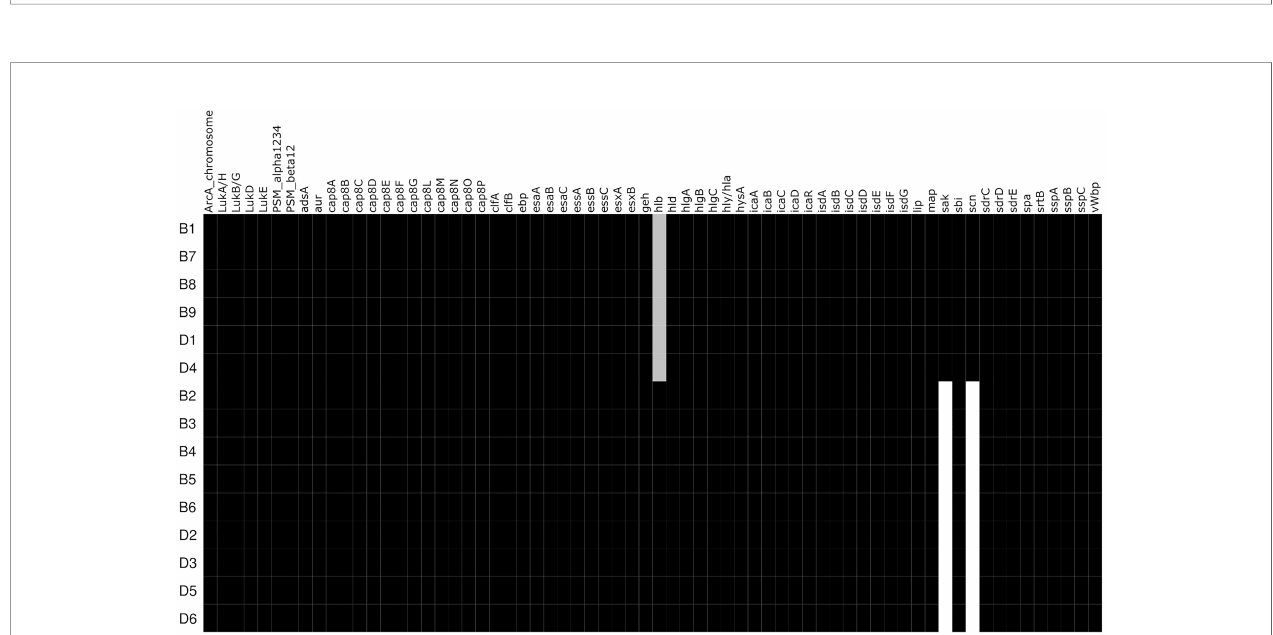
FIGURE 2 | Heatmap of detected virulence genes. Virulence factors that are present in the respective isolates are black while white represents absence. Grey shading represents a truncated